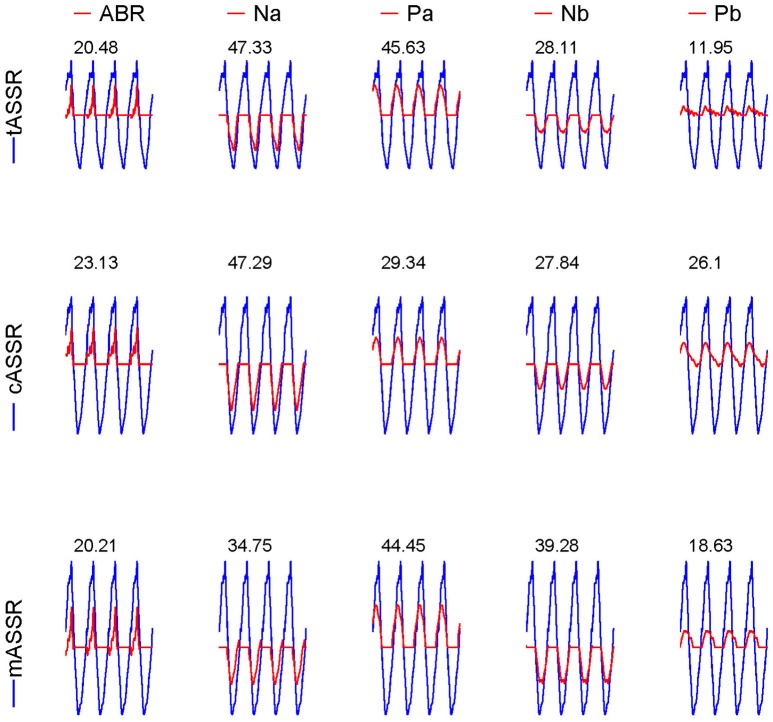
Contributions of AEP components to their corresponding ASSRs. Synthetic ASSRs (blue curves) superimposed by the whole AEPs are overlapped with the synthetic SSRs (red curves) superposed by one of the five components (ABR, Na, Pa, Nb, and Pb) displayed in columns for three paradigms (in rows). The RMS ratios (%) between red SSRs and blue ASSRs are labeled on the top of every subplot.